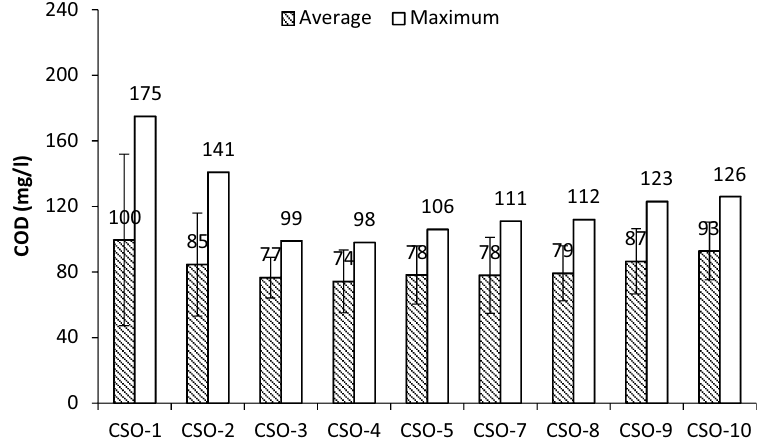
(a) Average (over the sampling period) and maximum concentra(cid:9)ons of BOD 5 (mg/l)